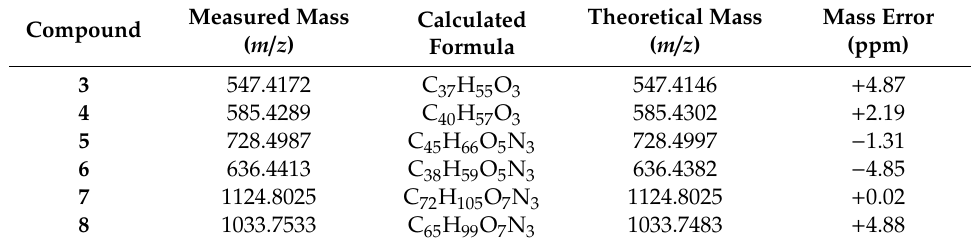
Table 2. HR-MS ESI of compounds 3 –